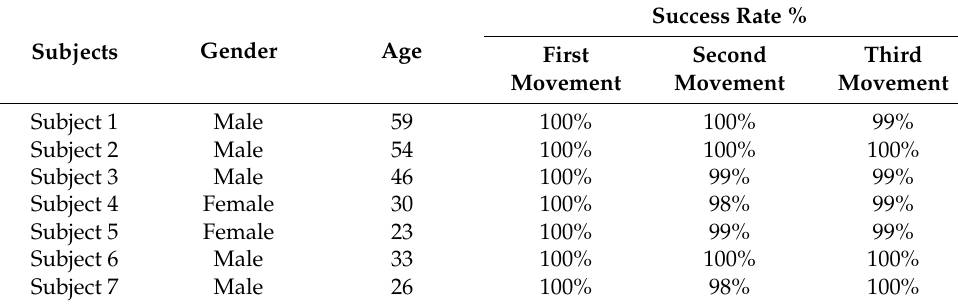
Table 2. Set of subject volunteers and